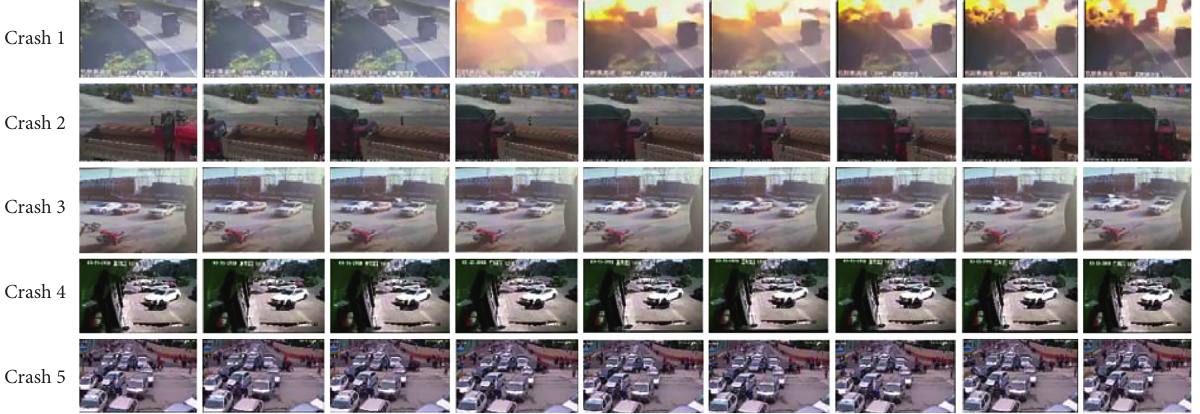
Figure 12: False-negative examples of model 6 (the best